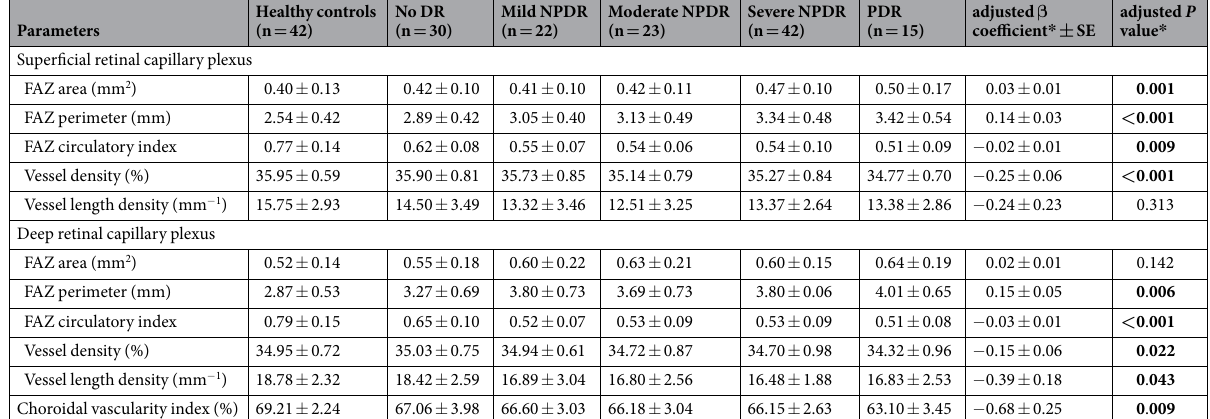
Table 2. Vascular parameters at the superficial and deep retinal capillary plexuses and the choroidal vasculature. Data are expressed as mean ± standard deviation (95% confidence interval). Linear mixed model. Factors with statistical significance are shown in bold. * Adjusted for age, sex, and diastolic blood pressure. DR, diabetic retinopathy; FAZ, foveal avascular zone; NPDR, non-proliferative diabetic retinopathy; PDR, proliferative diabetic retinopathy.